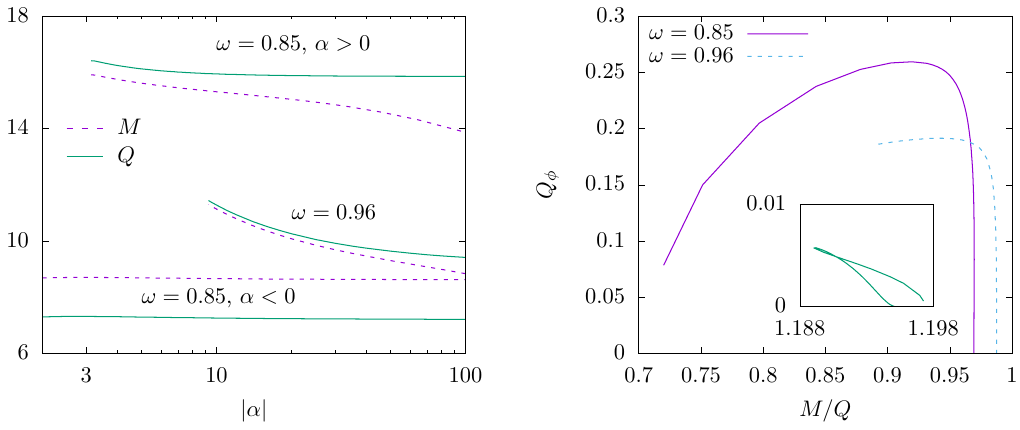
Figure 7 . Left: we show the mass M (purple dashed) and the Noether charge Q (green solid) of the fully backreacted scalarized boson star as function of the scalar-tensor coupling α for two different | | values of the frequency ω (right) including the positive and negative α branch, respectively, for ω = 0 . 85. Note that for ω = 0 . 96 only one branch of solutions exists. Right: we show the scalar charge Q φ in function of M/Q for ω = 0 . 85 (solid) and ω = 0 . 96 (dashed). For ω = 0 . 85 we give the values for the positive α branch (solid purple) and for the negative α branch (solid green, inset), respectively. sufficiently small γ = γ eq , the + branch and the branch join. For ψ 0 = 1 . 0, we find that − γ eq 0 . 2 with α eq ≈ − ≈